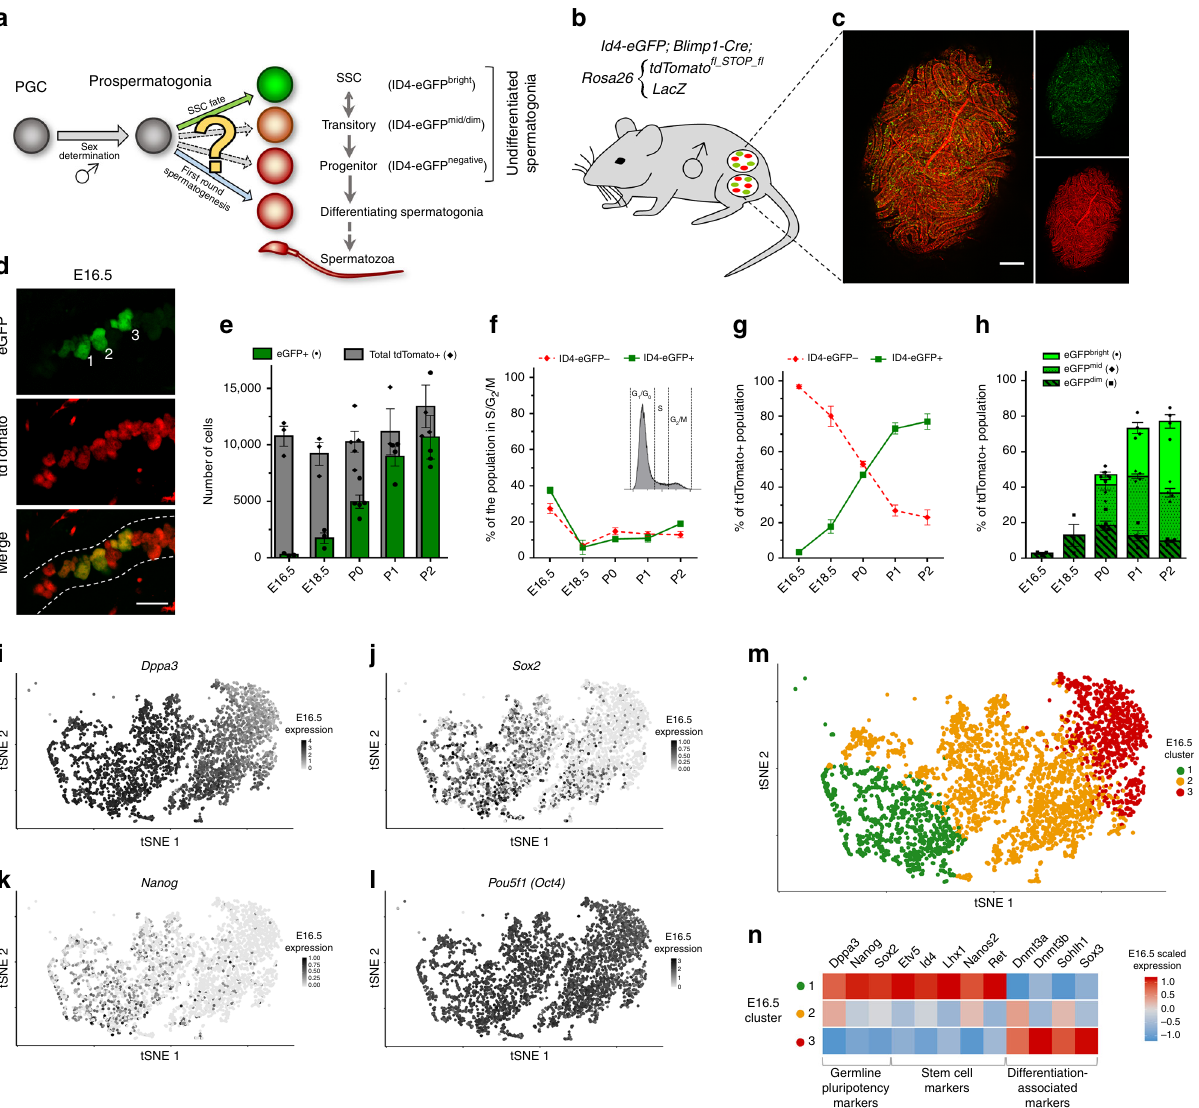
Fig. 1 Germ cell subsets emerge from a pool of quiescent prospermatogonia. a Schematic of germline development in males. b and c Transgenic mouse model ( b ) and representative images ( c ; scale bar, 200 µ M) for tdTomato fl uorescent labeling of the male mouse germline via Blimp1-Cre and in combination with Id4-eGfp transgene expression. d Representative images from whole-mount seminiferous cords of ID4-eGFP expression starting in E16.5 prospermatogonia (scale bar, 40 µ M). White dotted lines approximate seminiferous tubule borders and numbers identify clustering of eGFP + cells. e Flow cytometric analysis (FCA) of eGFP + and total germ cells. f – g FCA cell cycle analysis ( f ) and distribution ( g ) of ID4-eGFP − and ID4-eGFP + populations. h Quanti fi cation of ID4- eGFP distribution divided into Bright, Mid, and Dim subsets. i – l t-Distributed stochastic neighbor embedding (tSNE) representation of gene expression for select pluripotency markers, Dppa3 ( i ), Sox2 ( j ), Nanog ( k ), and Pou5f1/Oct4 ( l ), from scRNA-seq analysis of E16.5 germ cells. m and n Graph-based clustering results ( m ) and associated heatmap of select differentially expressed genes ( n ) from E16.5 prospermatogonia. FCA data in e – h are gated from all tdTomato + cells from isolated gonads (sample gating procedure located in Supplementary Fig. 2d). Quanti fi cations in e – h are presented as means with error bars representing SEM for n = 3 – 5 biologically independent animals per age point ( n = 3 for E16.5 and E18.5; n = 4 for P1 and P2; and n = 5 for P0). Source data are provided as a Source Data fi le. Transcriptome scRNA-seq analysis in i – n are representative of 3845 cells from n = 3 biologically independent